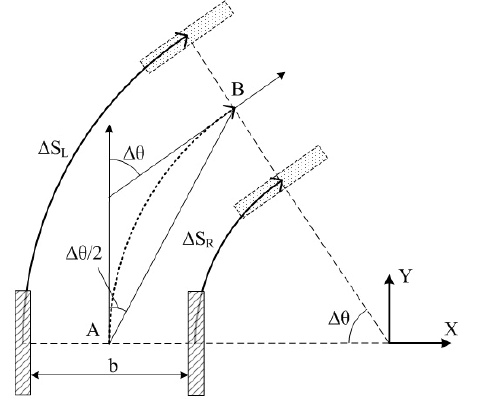
Figure 6. The principle of 2D pose calculation for the mobile